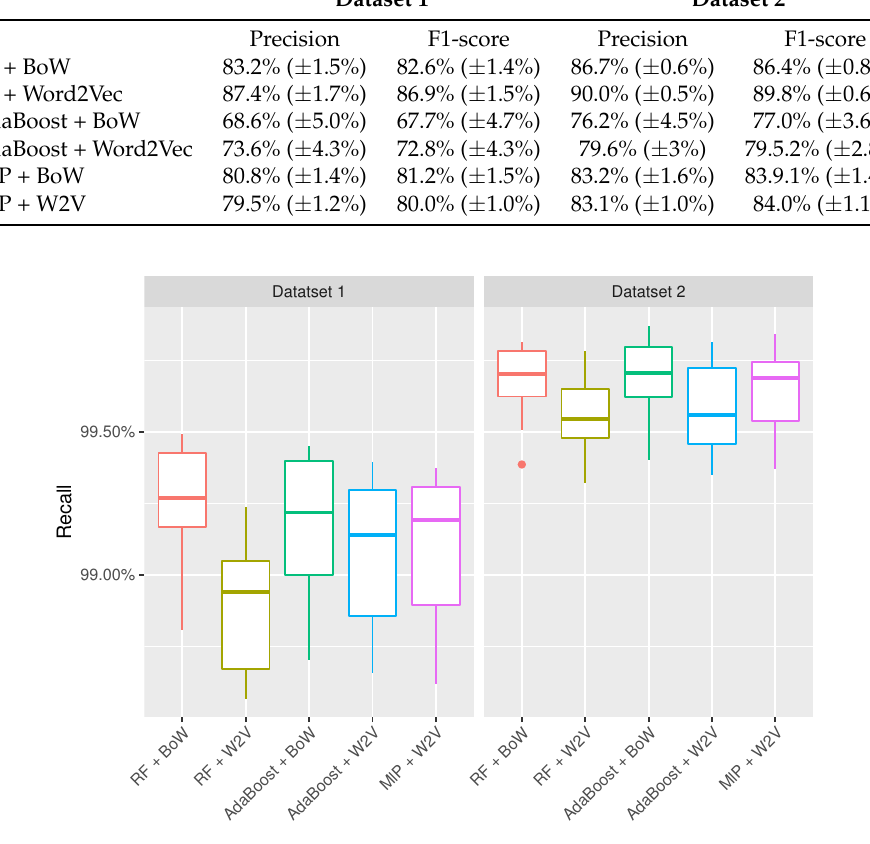
Figure 6. Cross validation values of the recall index for the prediction of the IVA codes (sent invoices).